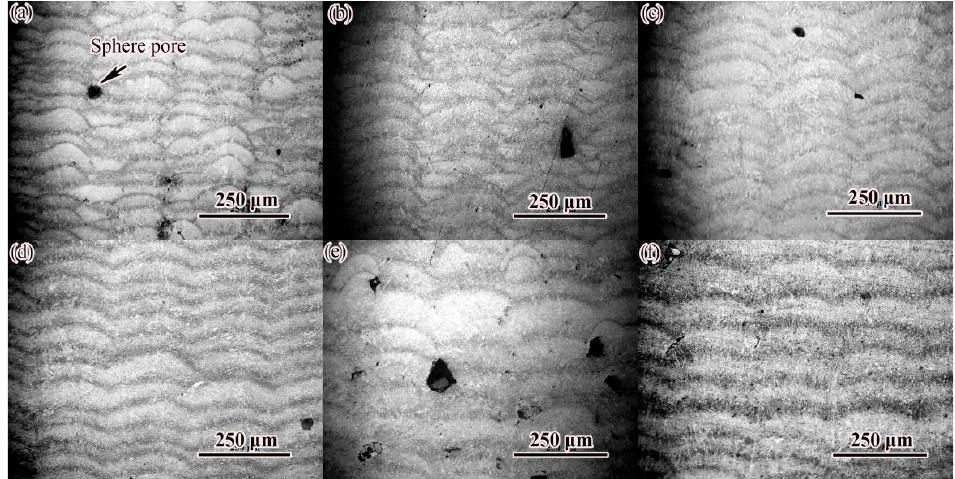
Figure 5. OM image of cross section of alloy steel formed by SLM at different scanning speeds: ( a ) V = 500 mm/s; ( b ) V = 600 mm/s; ( c ) V = 700 mm/s; ( d ) V = 800 mm/s; ( e ) V = 900 mm/s; ( f ) V = 1000 mm/s.